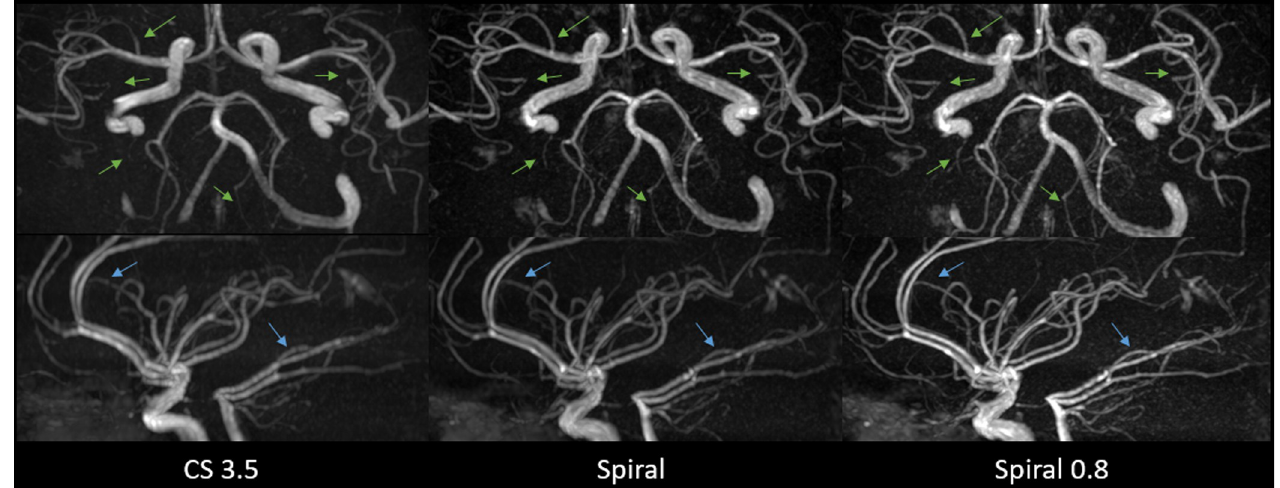
Fig 3. Axial and sagittal MIP images showing improved peripheral image quality on Spiral and Spiral 0.8 images as compared to CS 3.5 images. The green and blue arrows mark small vessels that do not appear on CS 3.5 images but are visible on Spiral and Spiral 0.8 images. Furthermore, an improved visualization of small peripheral vessels on Spiral and Spiral 0.8 images can be seen. Images were deliberately adjusted in terms of vessel hyperintensity to make differences in small vessel visualization more apparent.